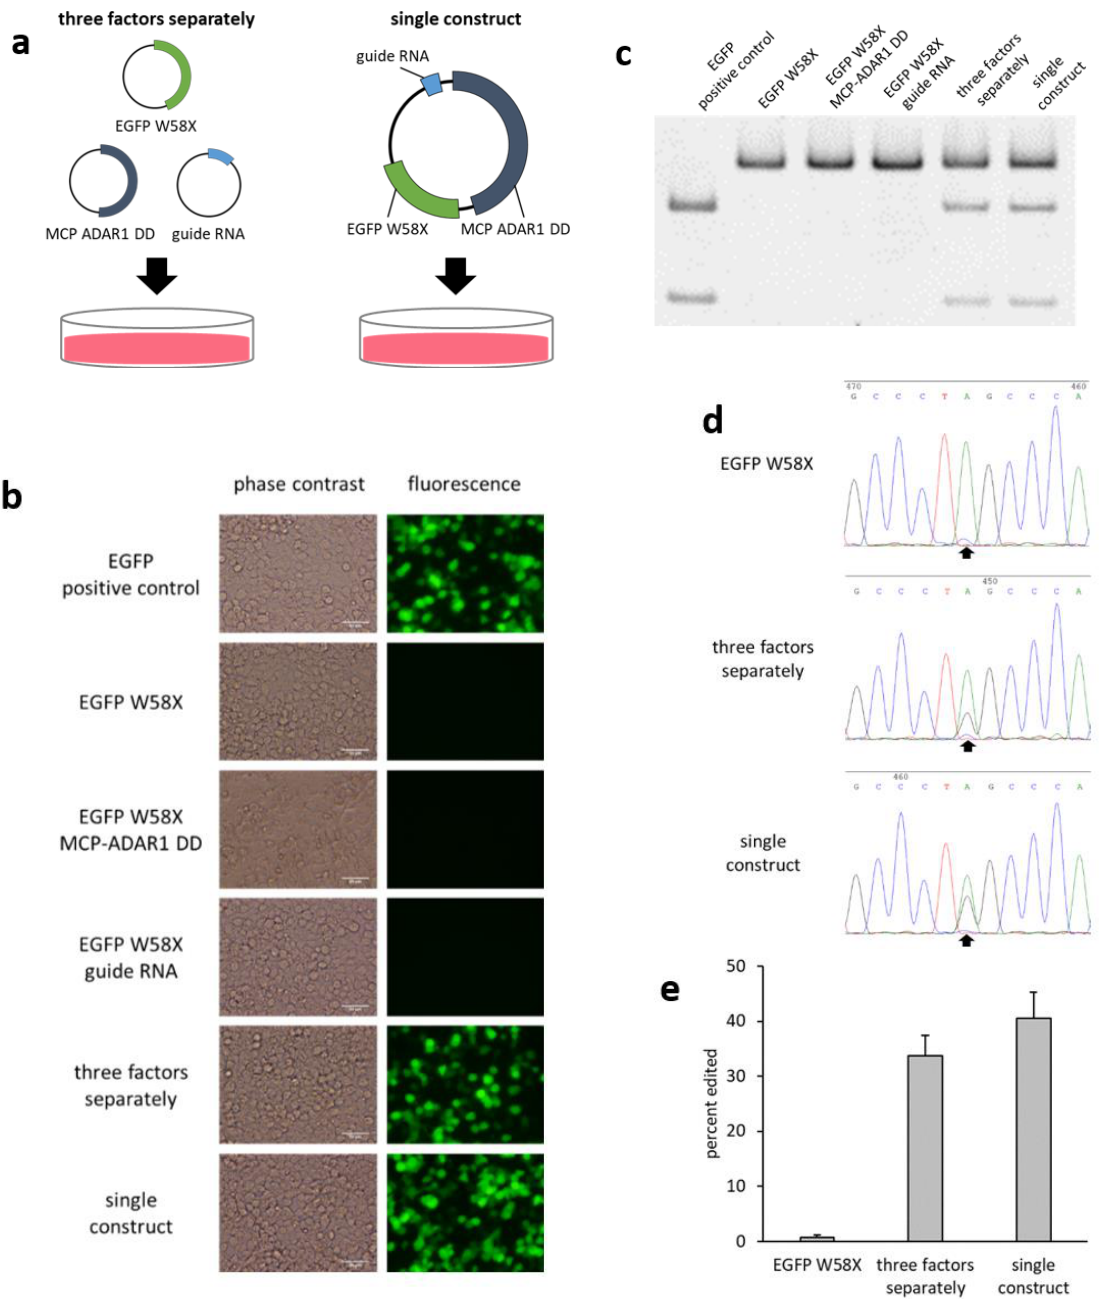
Figure 1. ( a ) The three factors were transfected into HEK293T cells using three separate plasmids each carrying a separate gene, or a single plasmid containing all three factors (single construct). ( b ) Fluorescence micrographs of HEK293T were obtained at 48 h after transfection (just before RNA collection). The images on the left are phase contrast images, and those on the right are fluorescence images. Scale bar = 50 µm. ( c ) At 48 h after transfection, RT-PCR products were digested by Hae III, and restriction fragment length polymorphism (RFLP) analysis was performed. ( d ) Waveform data around the target site from Sanger sequencing. Black arrows indicate the target base for EGFP W58X. ( e ) Bar graph showing the editing efficiency (%) calculated from the sequencing results using the peak height ratio method. Error bars represent standard error ( n = 3).